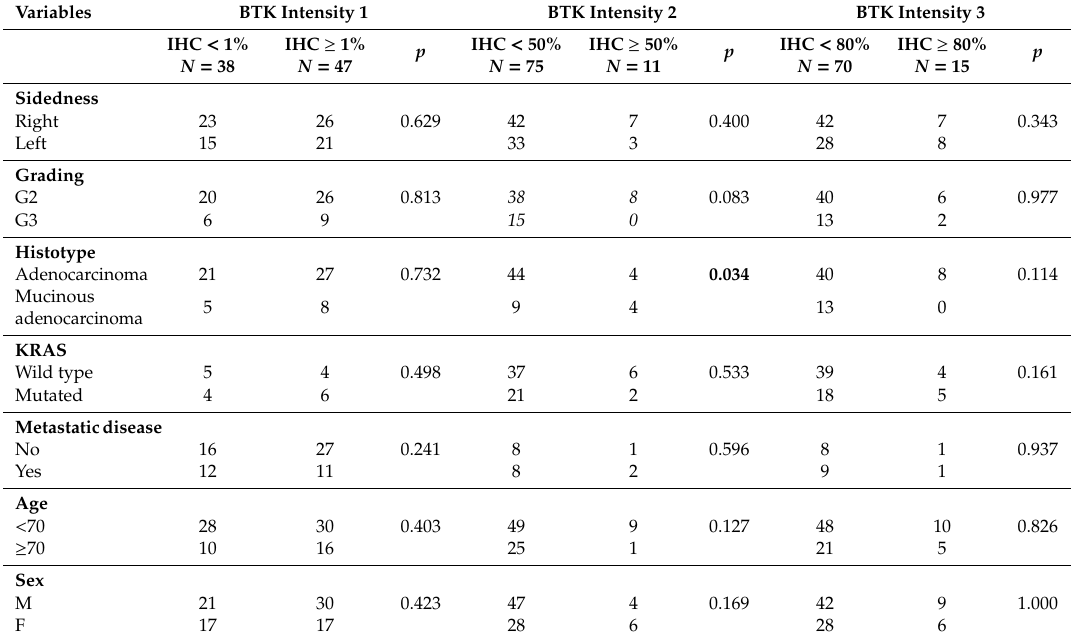
Table 2. Bruton’s tyrosine kinase (BTK) expression and clinico-pathological parameters.